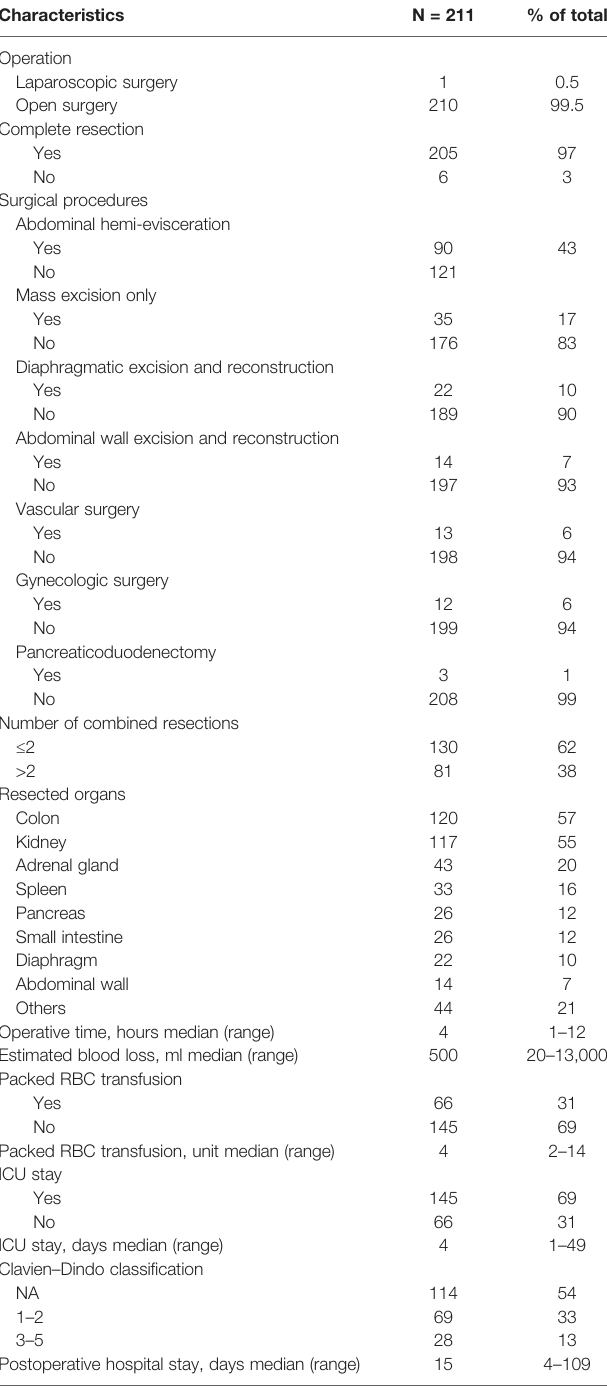
TABLE 3 | Surgical characteristics in 211 patients with primary retroperitoneal liposarcoma.